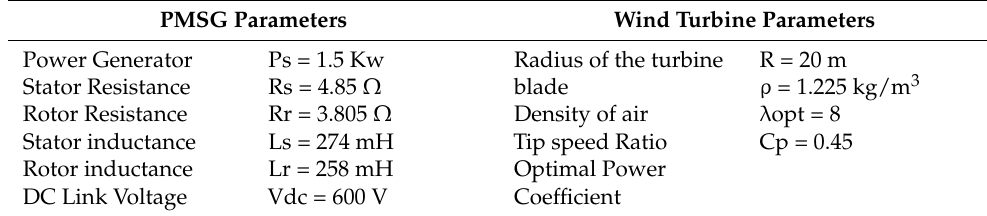
Figure 6. MPC control performance at step speed: ( a ) The wind profile; ( b ) The electromagnetic torque; ( c ) The active stator power ( d ) The stator reactive power; ( e ) Rotor quadrature current; ( f ) Rotor direct current; ( g ) Stator currents; ( h ) Rotor currents; ( i ) Dc link voltage. Table 1. The DFIG and wind turbine parameters.